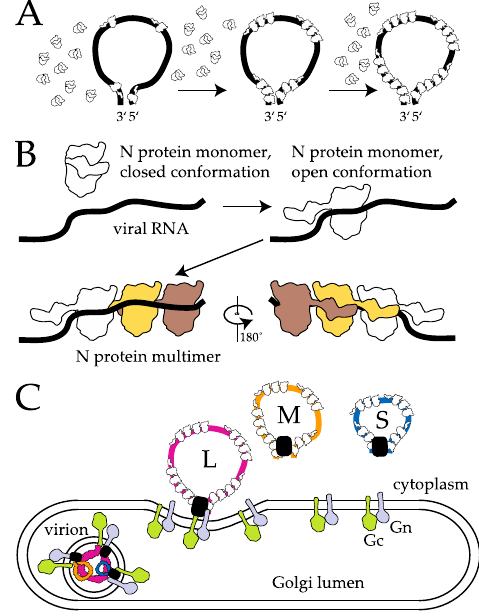
Figure 2. Levels of molecular interactions contributing to RNA packaging during phlebovirus replication discussed in this review. ( A ) Formation of the RNP complex. Genomic RNA segments have complementary 5 ′ and 3 ′ ends, contributing to the characteristic panhandle structure. Nucleocapsid (N) proteins, exhibit some sequence and/or structure preference on target RNAs and binds to recognition site(s), nucleating further cooperative N ‐ RNA binding events; ( B ) Model for RNA dependent conformational change of N. The RNA binding cleft of N protein is occluded by the amino-terminal arm until it encounters a cognate RNA binding site. Upon binding, the amino-terminal arm swings open and recruits non-sequence specific binding of further N molecules along the RNA. The back view shows placement of the amino terminal arm of each monomer on the outside hydrophobic cleft of the adjacent N monomer; ( C ) Higher-order packaging interactions. Budding of the small (S), medium (M), and large (L) genomic RNA segments, which are likely fully coated with N protein to form RNPs, occurs at the Golgi membrane, and may be promoted by interactions between the RNPs and the RNA dependent RNA polymerase, or L protein (symbolized by black boxes), and the glycoproteins Gc and Gn. The mechanism(s) for selecting one of each of the genomic RNPs per virus particle are still an active area of investigation, and may include RNA-RNA, RNP-RNP, and/or protein-protein interactions.